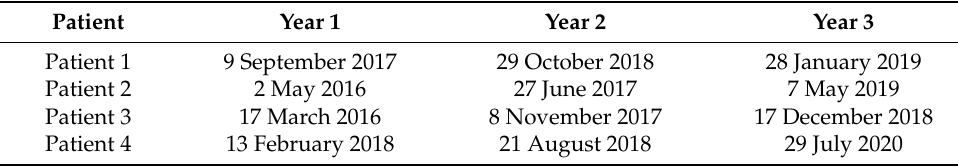
Table 3. Dates of images taken for each